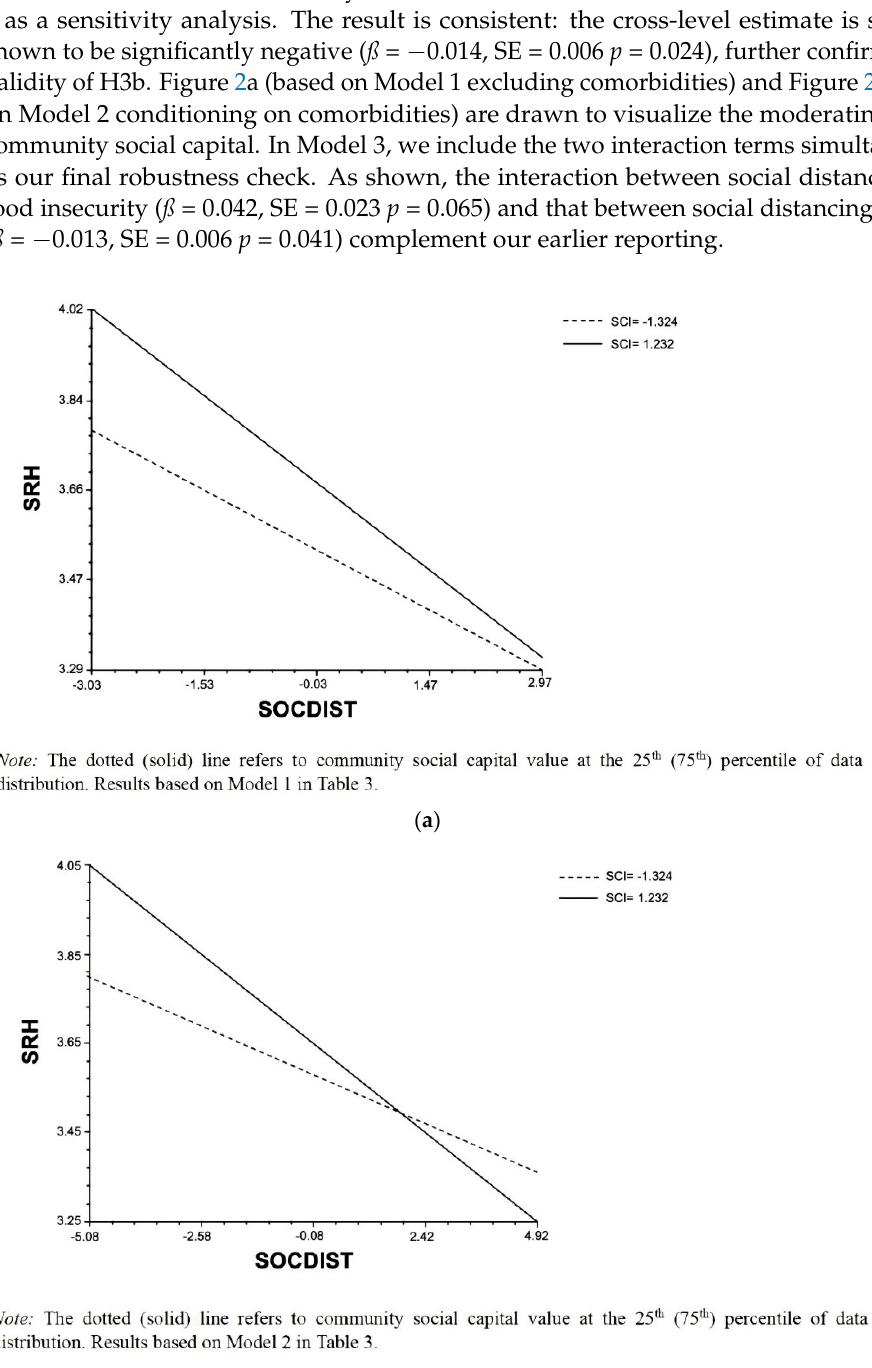
Figure 2. Relationship between Social Distancing and Self ‐ Rated Health Moderated by Community Social Capital: ( a ) Not Controlling for Comorbidities ( b ) Controlling for Comorbidities.